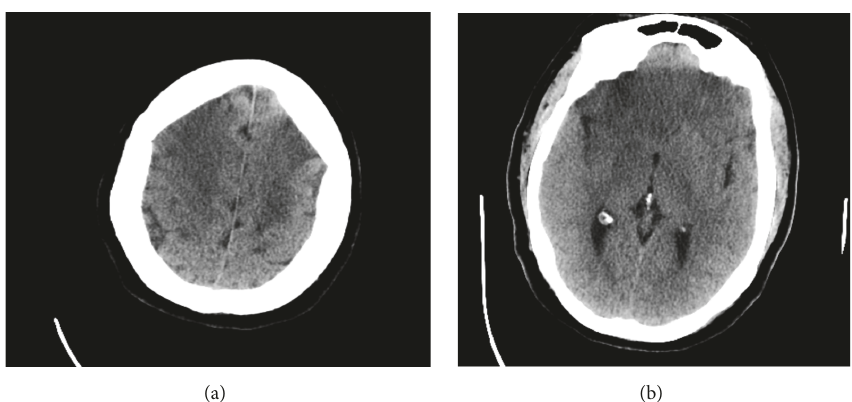
Figure 2: Axial CT images demonstrating bilateral large areas of hypoattenuation consistent with acute MCA and ACA infarcts.